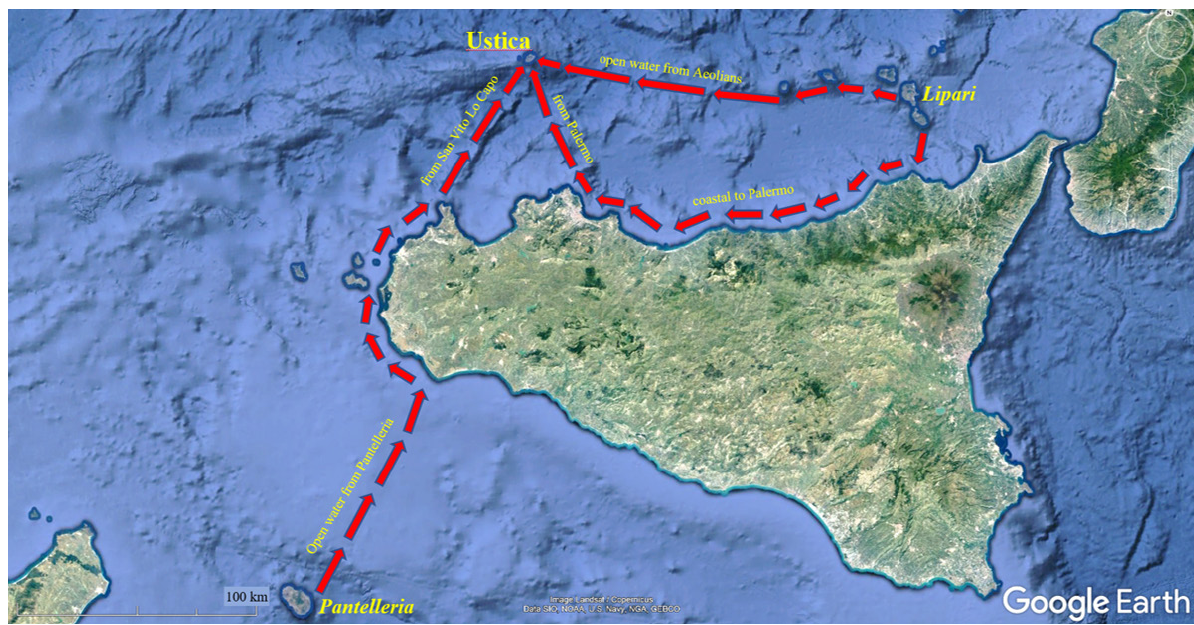
Figure 10: Map of potential routes for obsidian reaching